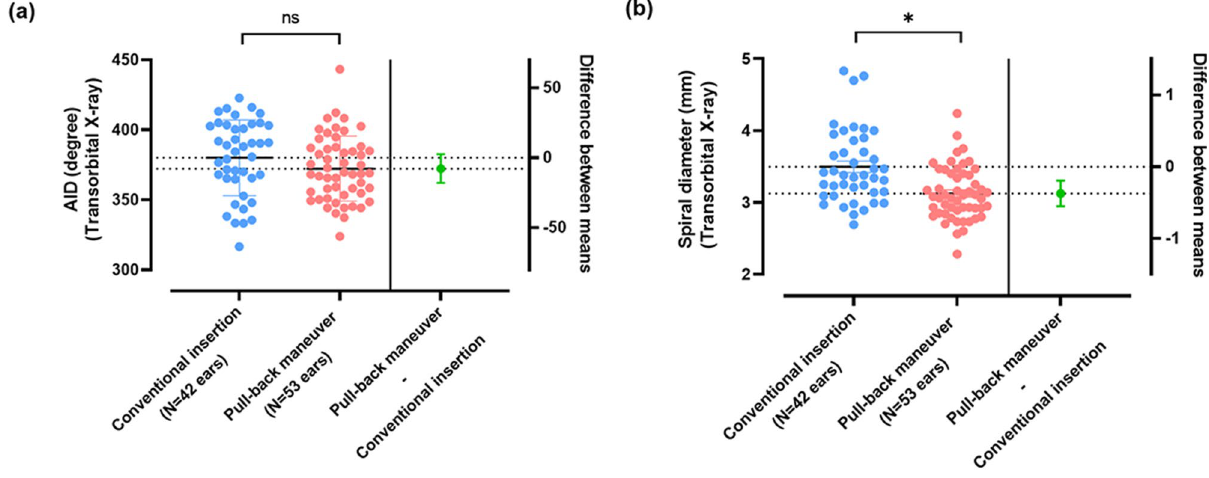
Figure 2. Comparison of spiral diameter and angular insertion depth between conventional insertion and pull-back maneuver groups. ( a ) The angular insertion depth is similar regardless of the insertion technique employed. The pull-back maneuver-assisted insertion did not elicit a significant decrease in angular insertion depth relative to that with conventional insertion. ( b ) The spiral diameter reflecting modiolar proximity was significantly different between insertion techniques. The pull-back maneuver group had significantly reduced spiral diameter as measured by transorbital X-ray, as compared with conventional insertion group. The pull- back maneuver-assisted insertion gives rise to enhancing modiolar proximity of slim modiolar electrodes in vivo. Data are means ± standard error of mean (SEMs). * P < 0.05 by independent t-test. ns no statistical